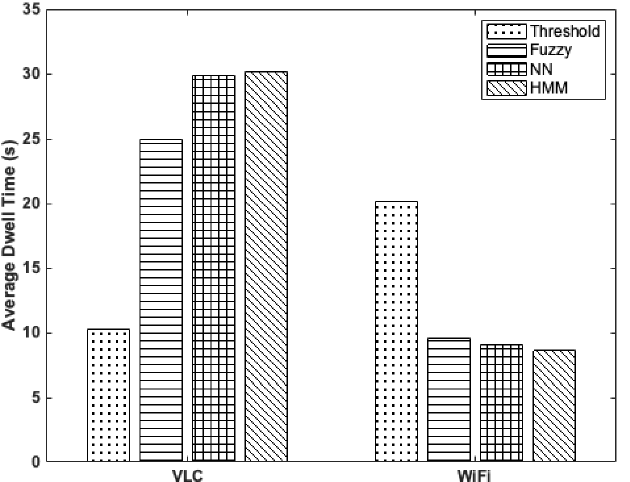
Figure 5. Average dwell time comparison of the VLC and WiFi systems using HMM, Fuzzy, NN, Threshold methods.